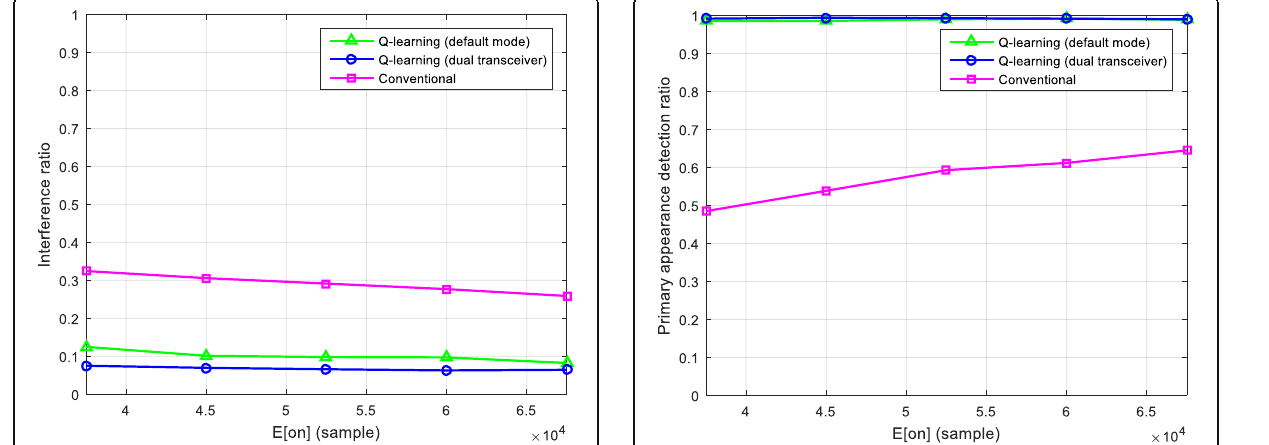
Fig. 18 PU existence count ratio according to E [on]. Shows the detection ratio of the number of PU appearances according to the ratio of E [on]. The proposed method has a high value in all regions because it continuously sense the channel. However, the conventional method cannot detect if the PU appears only in the data transmission interval because the sensing and transmission intervals are alternately performed. The conventional method increases the PU existence count ratio because E [on] increases the probability that the sensing interval overlaps with the PU busy